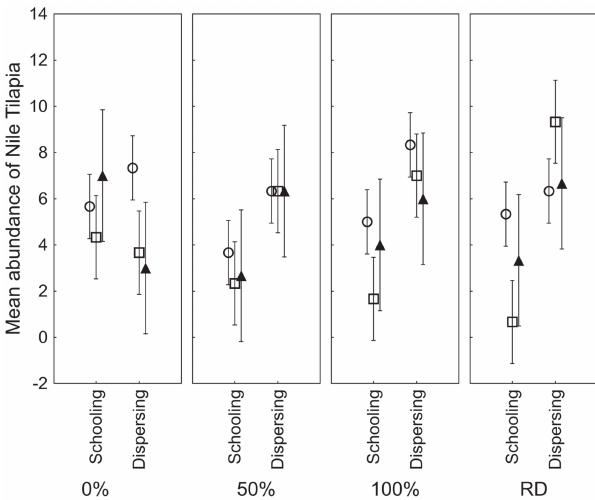
Fig. 9 . Defense strategy (schooling and dispersing) by the Nile Tilapia (mean ± SD) in the tanks with Pseudoplatystoma corruscans (white circles), Salminus brasiliensis (white squares) and Brycon orbignyanus (black triangles), for 0%, 50%, 100% and RD treatments. The three-way ANOVA for these data showed interaction (P =0.018) among species, structural complexity and schooling. Shoaling decreased for 0% to 100% structural complexity treatments, while dispersing behavior increased for the RD